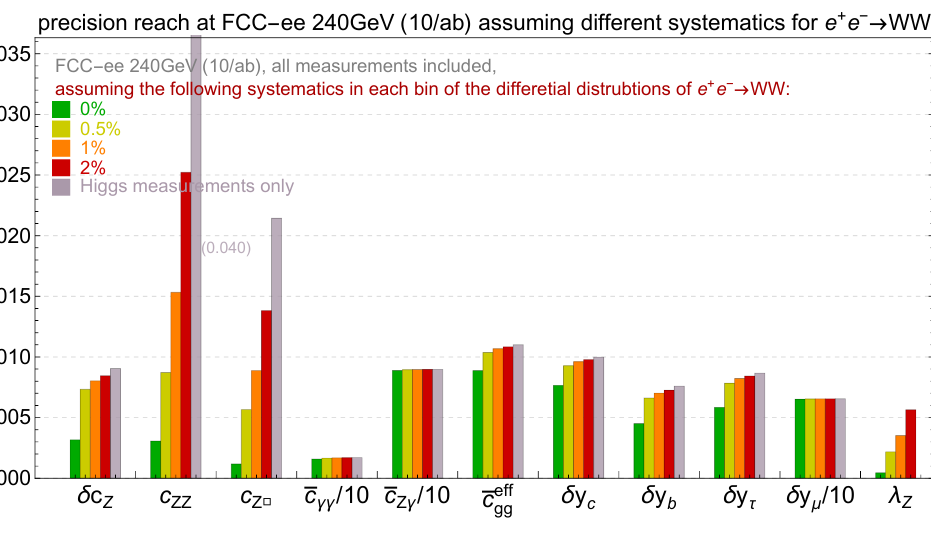
Figure 20 . Same as (cid:12)gure 12 but for FCC-ee 240 GeV with 10 ab (cid:0) 1